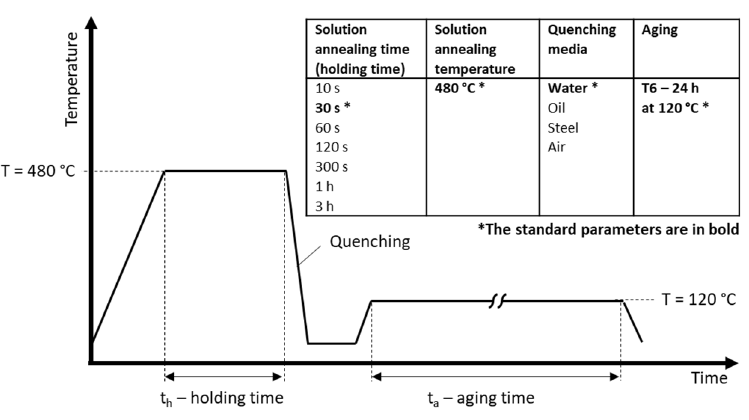
Figure 3. Standard heat treatment parameters for the PWHT.